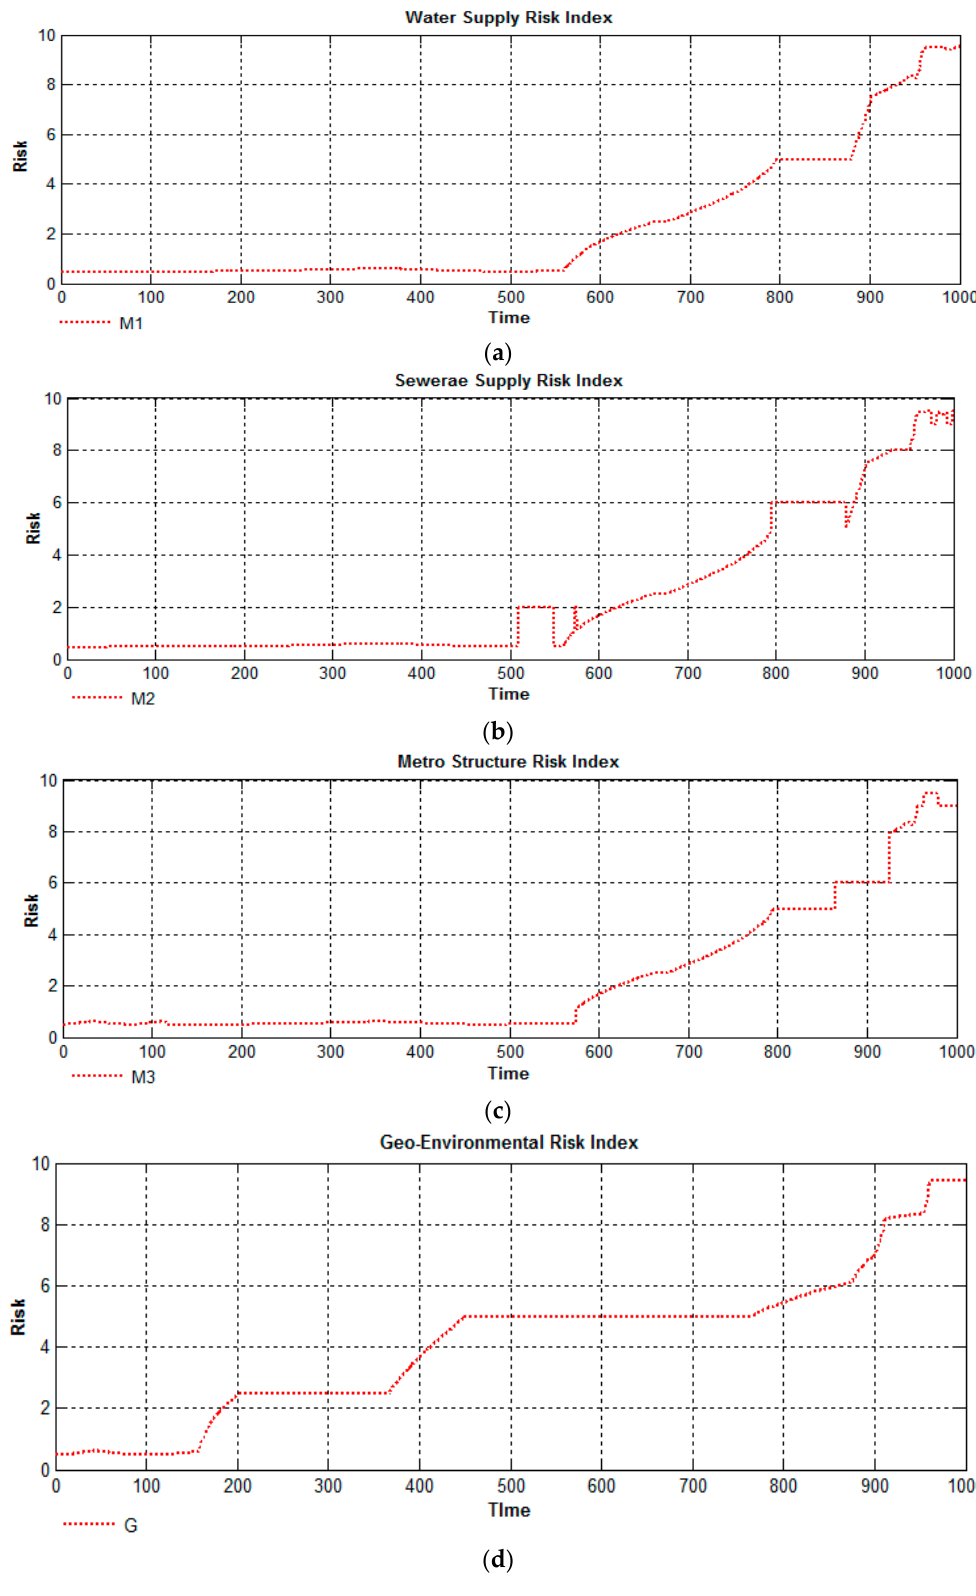
Figure 12. ( a – c ) and ( d ) are output risk index of fuzzy logics in blended layer. The collaborative layer has two fuzzy components, i.e., CR 1 and CR 2 . The average rule-based mechanism has been applied for these two fuzzy logics. The output of M 1 and M 2 fuzzy logics from the blended layer is given as inputs to CR 1 fuzzy logic. Similarly, outputs of M 3 and G fuzzy logic are